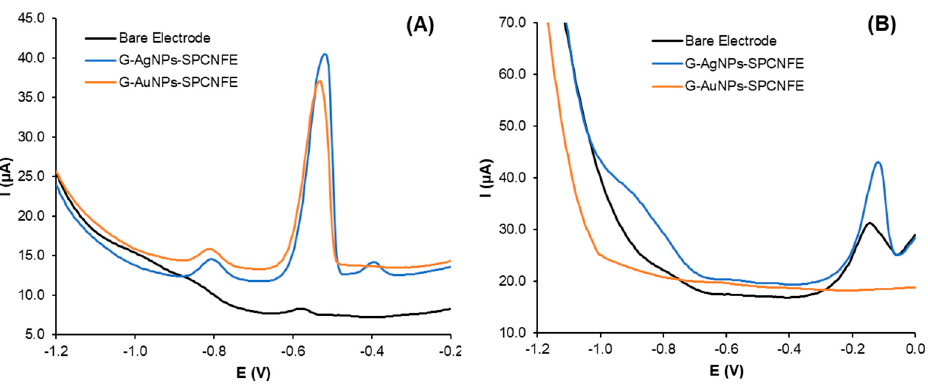
Figure 5. Comparative study using the bare electrode and the green nanoparticles modified elec- trode for a fixed concentration of 75 µg L − 1 of ( A ) Cd(II) and Pb(II) analytes and ( B ) U(VI) analyte.